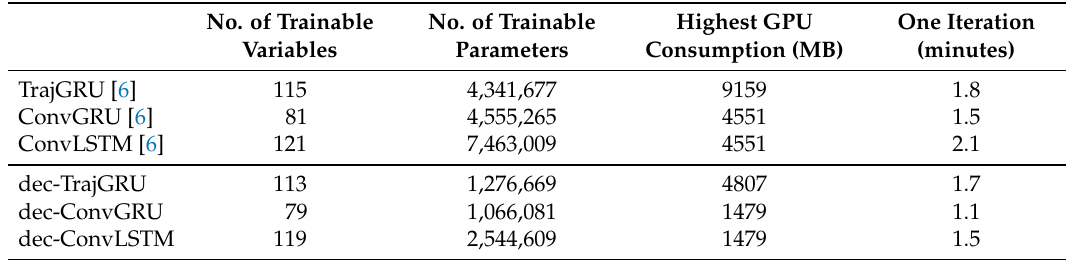
Table A1. Network sizes and training costs of the models adapted from [6] (the top three rows) and our proposed dec-seq2seq models (the bottom three rows). Because of the early stopping technique, models might terminate after different numbers of iterations, hence we reported the average time of one iteration